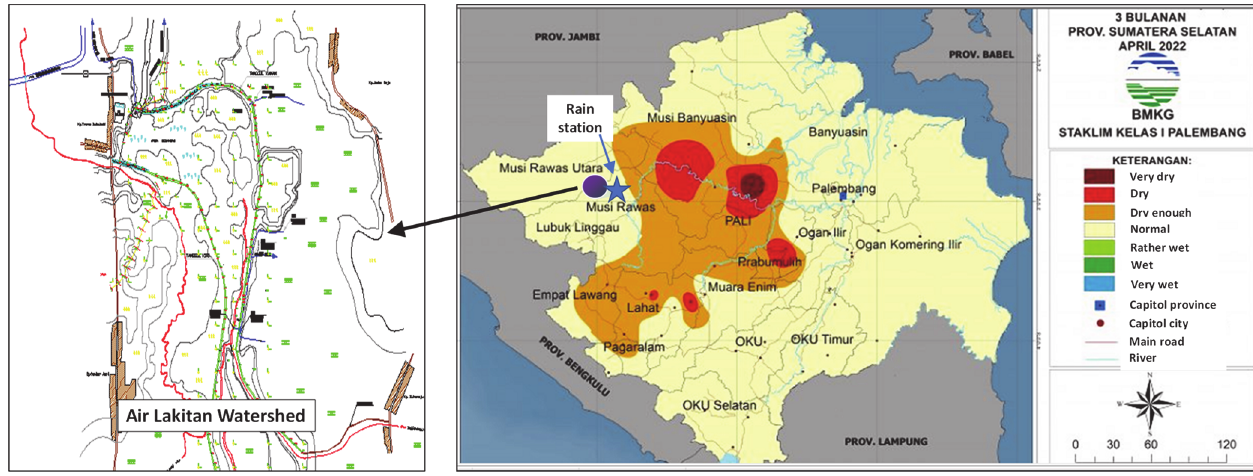
Figure 1. The location of the research